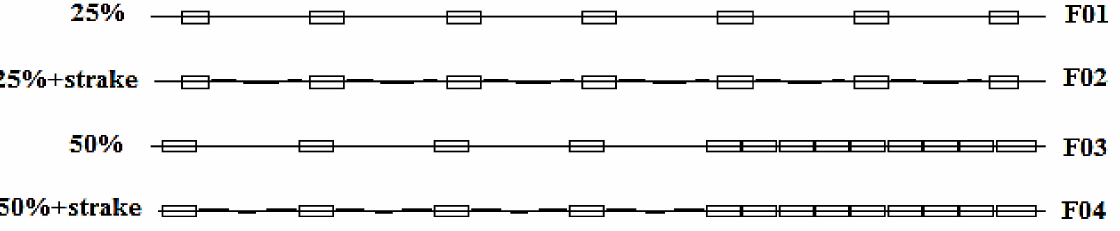
Figure 4. Four distribution forms of buoyancy modules and